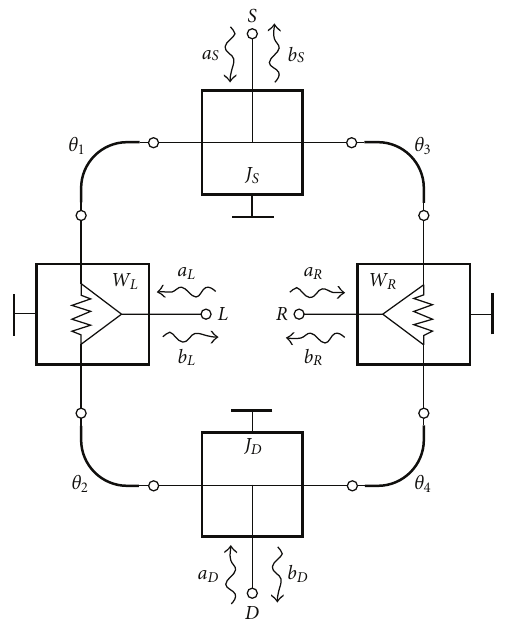
Figure 8: Diagram of the feeding network for the direction finding